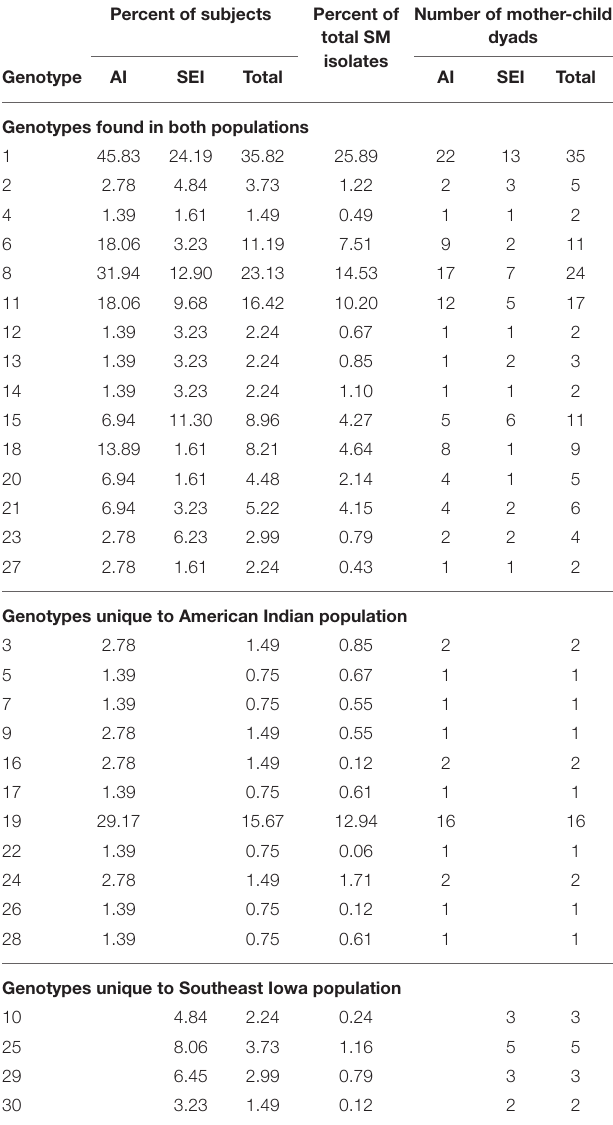
TABLE 2 | Distribution of S. mutans (SM) genotypes in subjects with detectable levels of SM present. Number of mother-child Percent of subjects Percent of total SM isolates